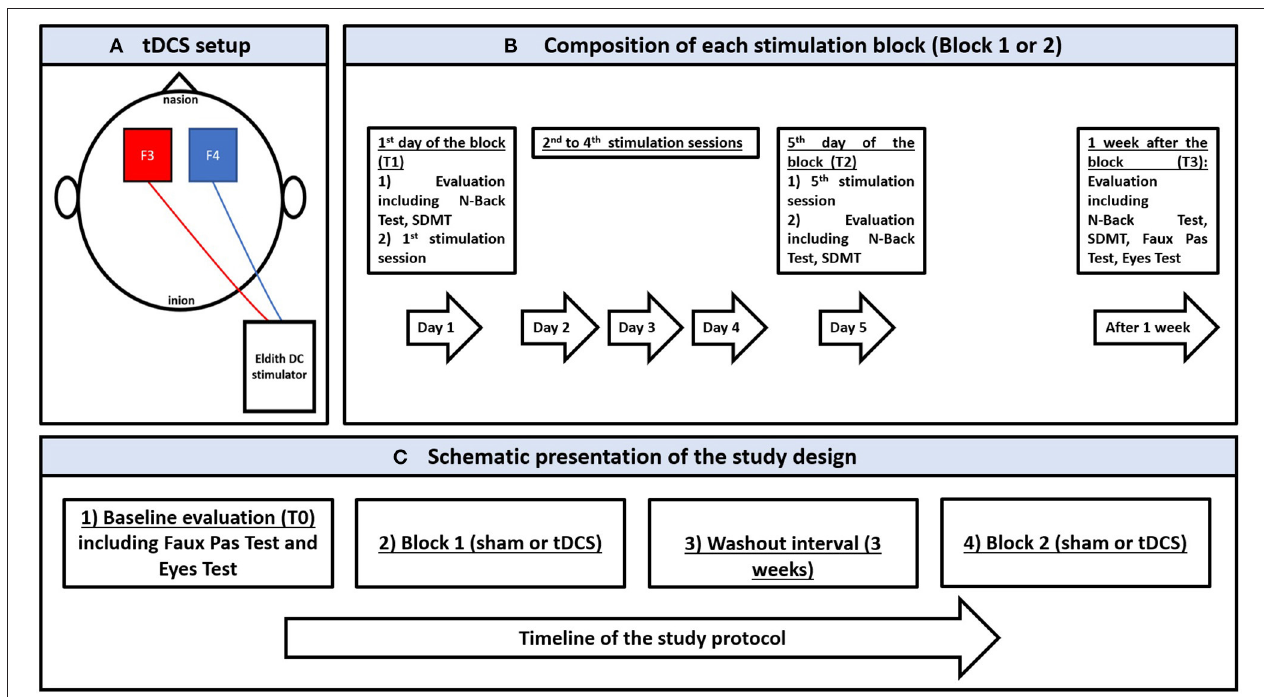
FIGURE 1 | (A) schematic presentation of the transcranial direct stimulation setup showing the anode (in red) and the cathode (in blue) over F3 and F4, respectively, according to the 10–20 international electroencephalographic system for electrode positioning; the electrodes are connected to a battery-driver direct current stimulator. (B) schematic presentation of a stimulation block (sham or active) showing the stimulation and evaluation sessions between the 1st day of stimulation and 1 week after the last stimulation. (C) schematic presentation of the study protocol showing the chronological order of experimentation. SDMT: Symbol Digit Modalities